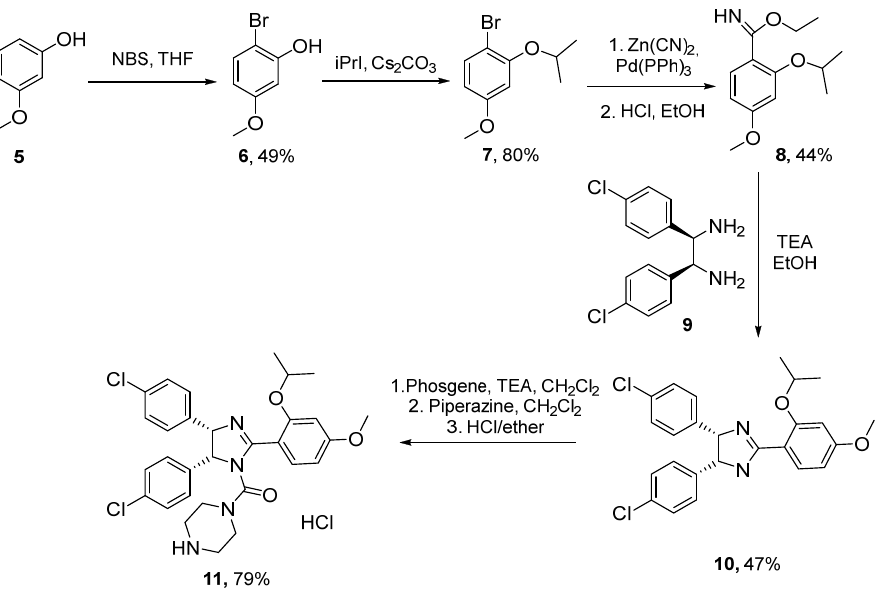
Figure 3. (a) MDM2 protein fragment with the Nutlin-3a inhibitor located at the p53 binding site. ( b ) Nutlin-3 overlay (carbon atoms are marked in white, nitrogen atoms in blue, oxygen atoms in red, and bromine in brown) and amino acid fragments of Phe19, Trp23, and Leu26 of the p53 protein. ( c ) The surface of the p53– MDM2 binding site (hollows are marked in green, and convex sections in red), showing one bromophenyl group located deep in the Trp